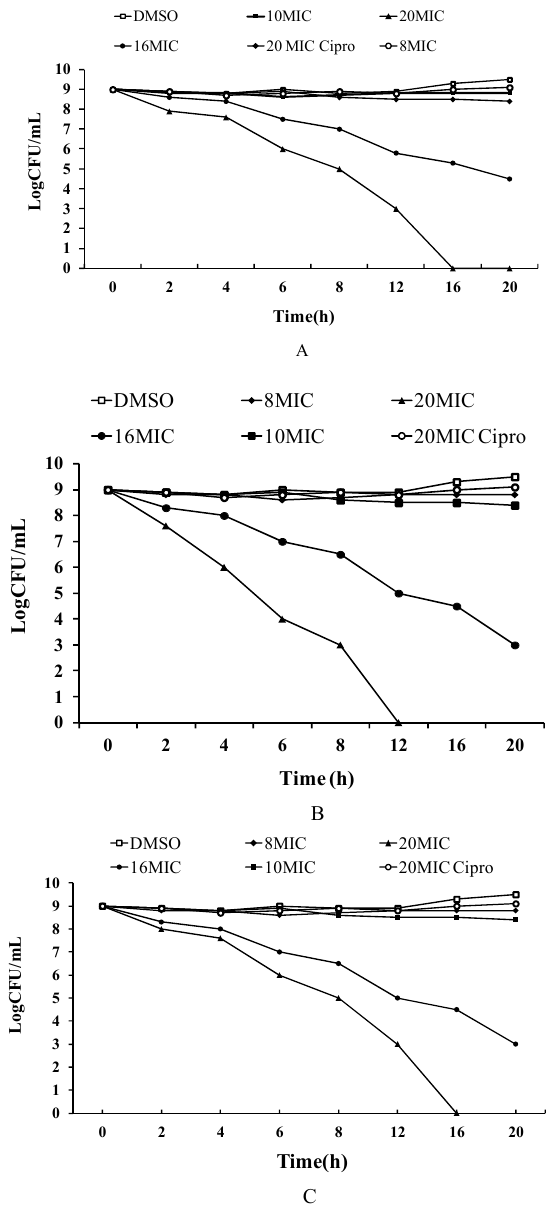
Figure 4. The ability of cyclic peptide-1 ( A ), cyclic peptide-11 ( B ), and cyclic peptide-14 ( C ) to kill MRSA ATCC43300 persisters.